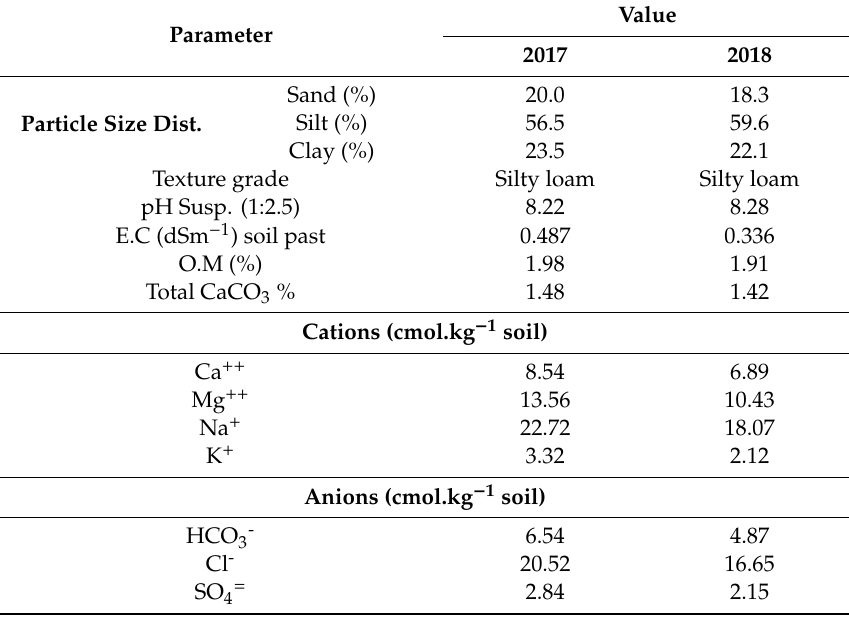
Value 2017 2018